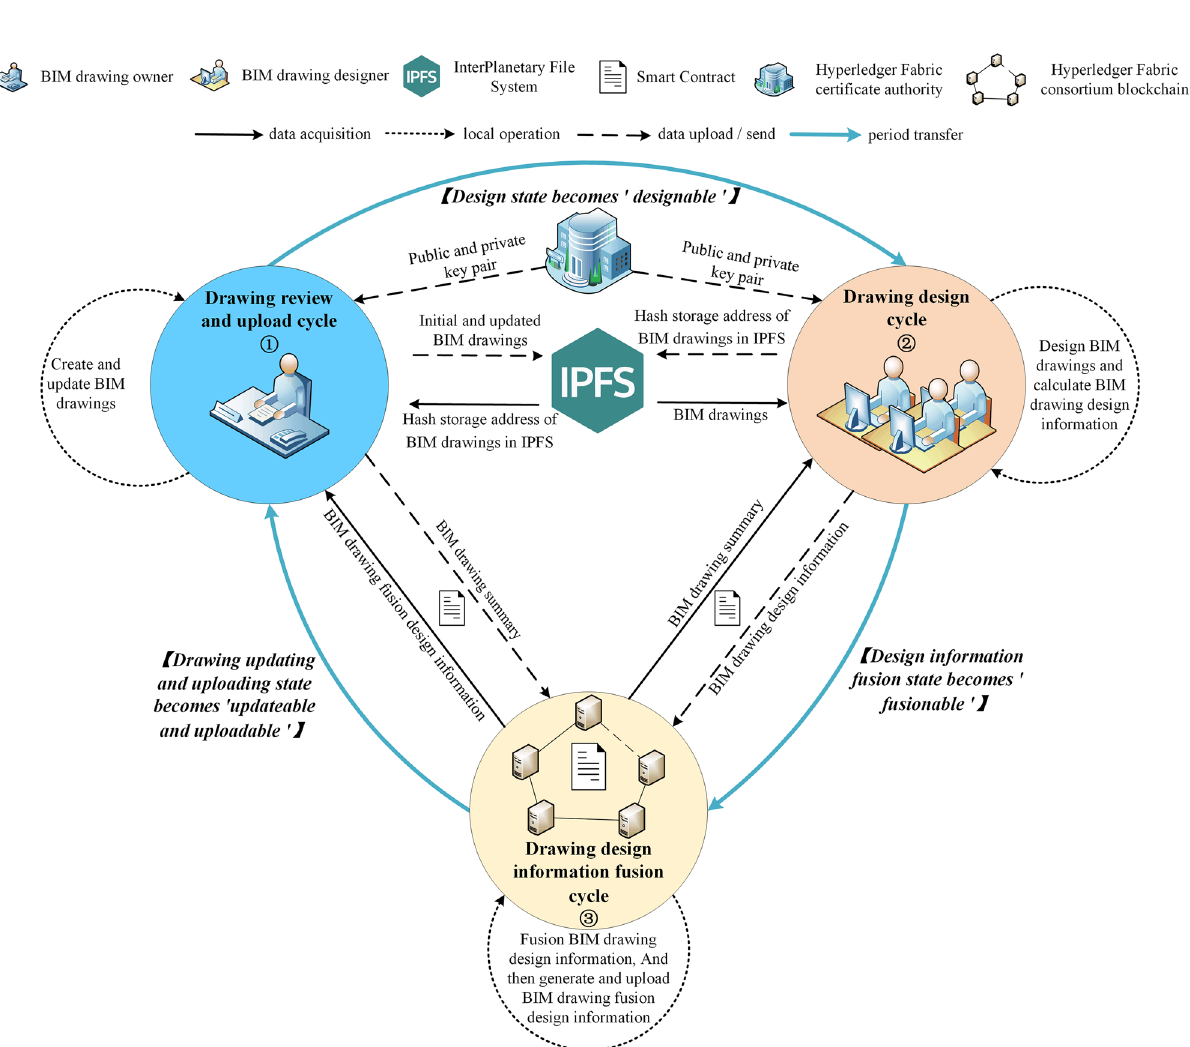
Figure 1. The logical framework of multi-person collaborative design of BIM drawing based on